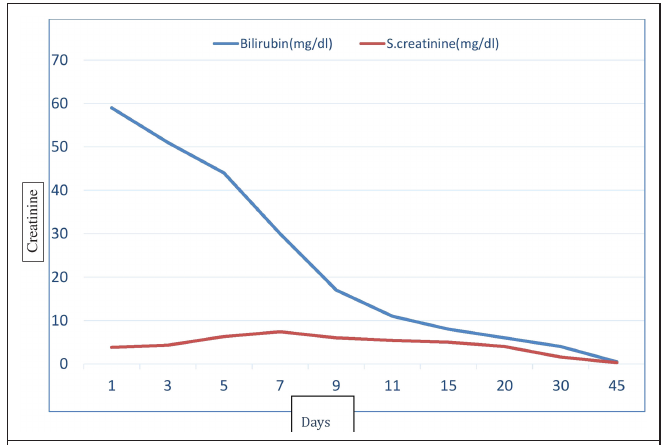
Figure 3. Trends of serum bilirubin and serum